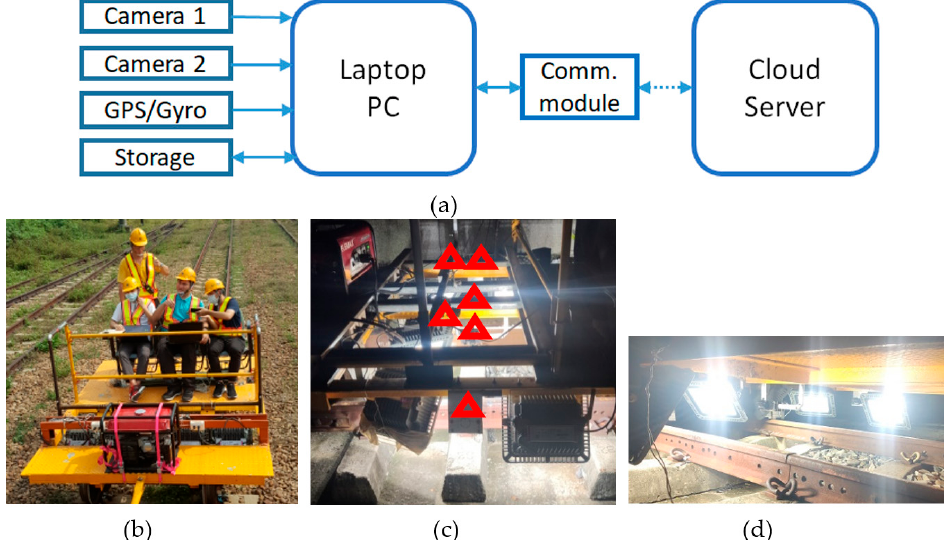
Figure 1. System architecture. ( a ) system schematic diagram; ( b ) a flat patrol car; ( c ) the red triangles are the positions of the cameras; ( d ) LED lights are used for the illumination.